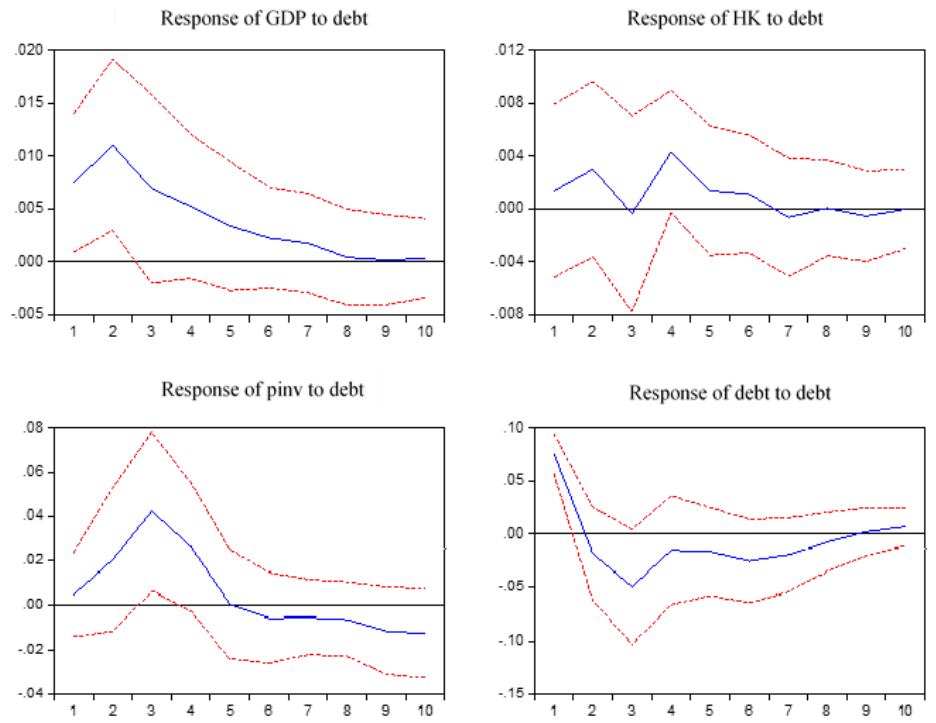
Figure 6: Response of Government Debt, Private Investment, Per Capita Output and Hu - man Capital Stock to a Generalized 1 SD Innovation in Government Debt, Thailand, 1985 -2019